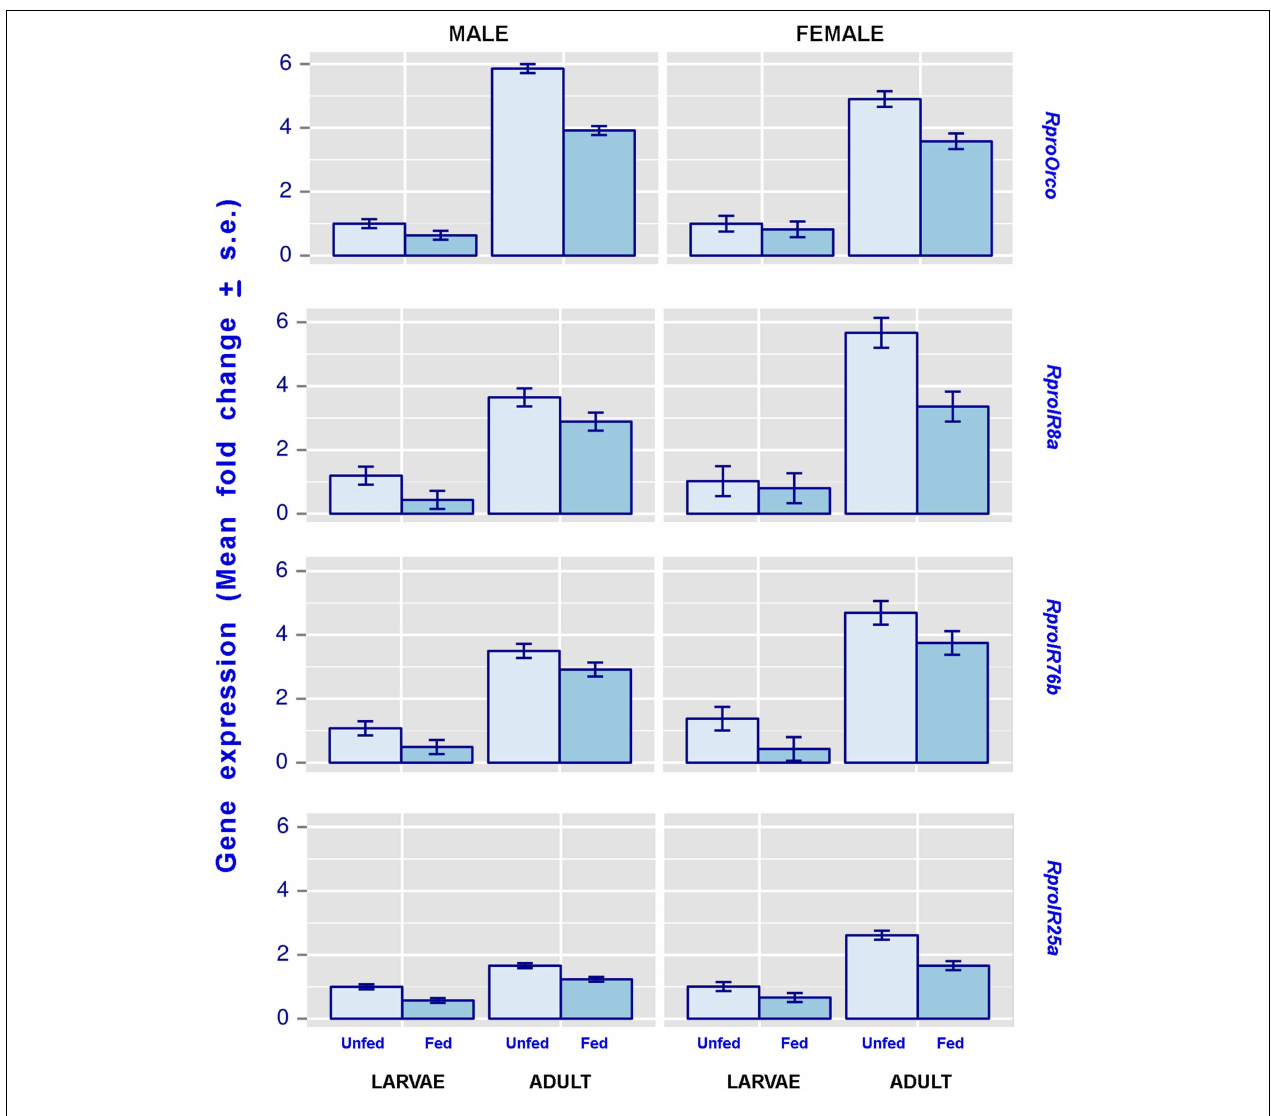
FIGURE 1 | The effect of imaginal molt and nutrition on male and female olfactory coreceptor gene expression levels, as seen in the antennae of 5 th instar larvae and adults. Both 5 th instar larvae and adults included in this figure were 21 day-old. Error bars represent the standard